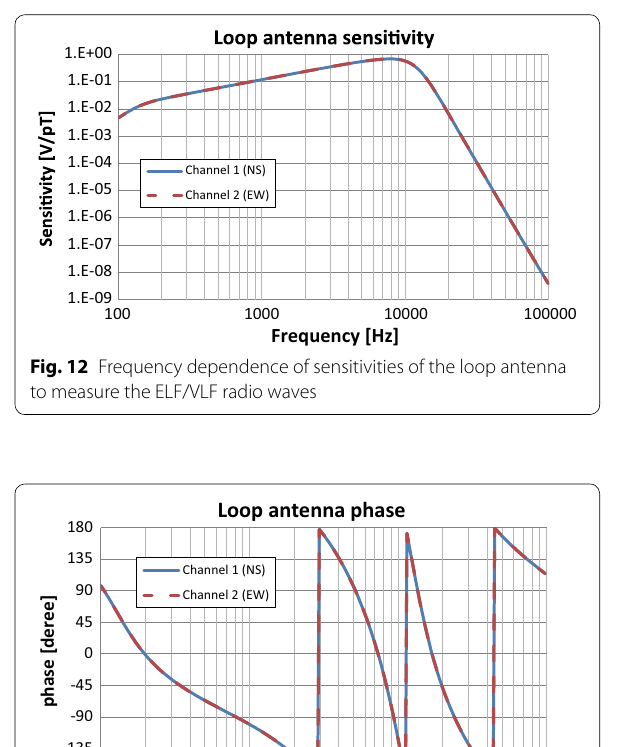
campaign. Vertical dashed lines in each panel indicate the location of magnetic midnight. The contamination from global lightning activities is seen at frequencies